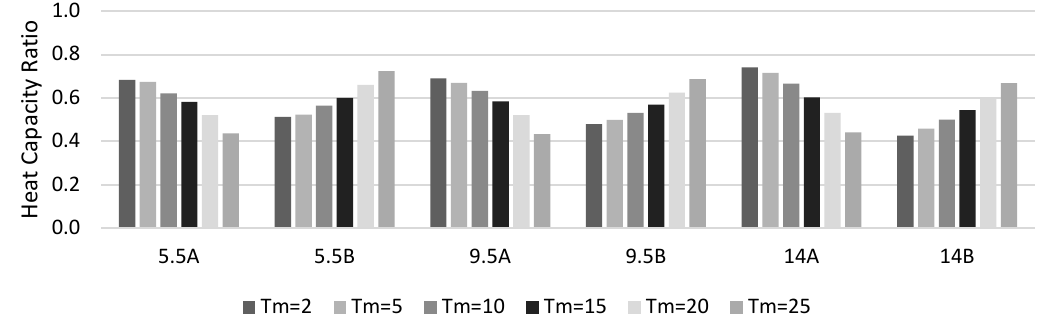
Figure 8. Heat capacity ratios for all simulated cases for heat exchanger 2.